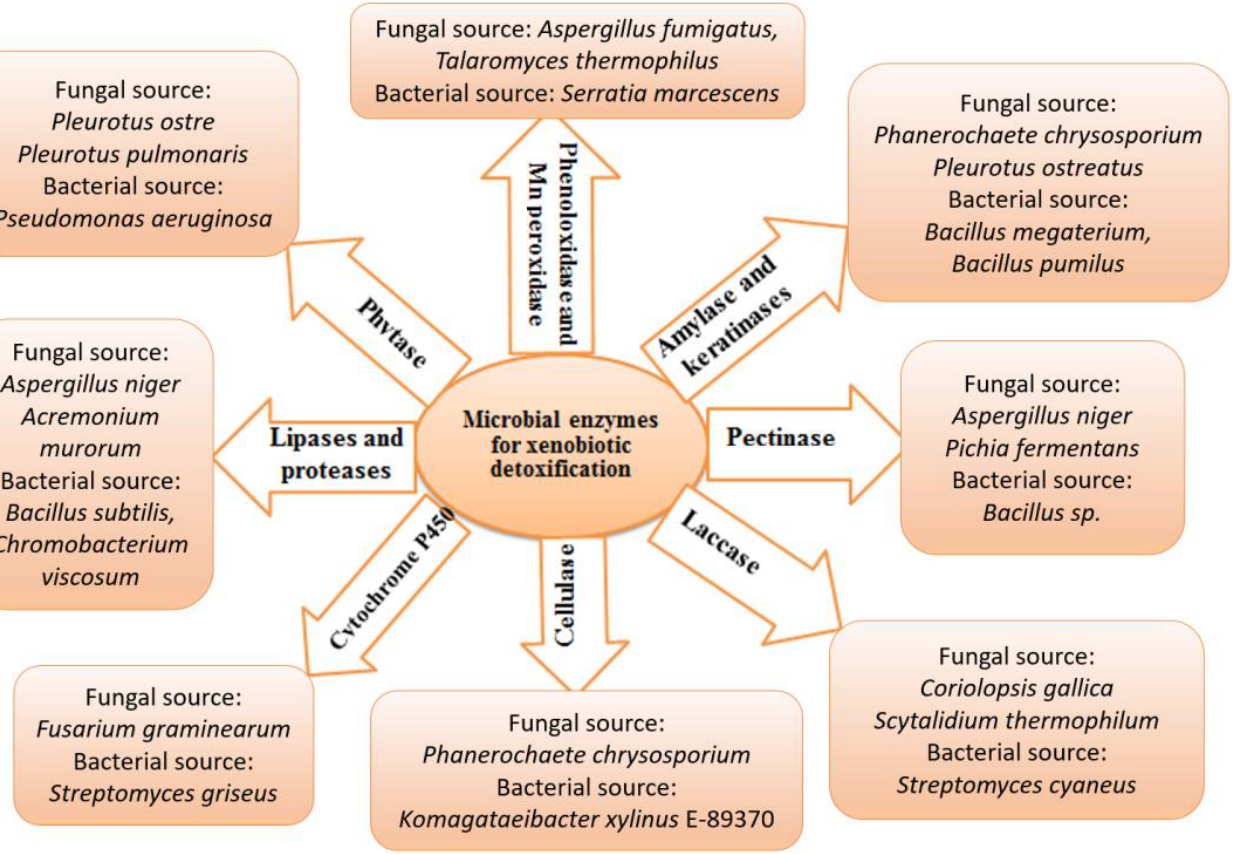
Figure 4. Microbial enzymes in xenobiotic management. This figure summarizes a few representative enzymes and their corresponding microbial sources involved in xenobiotic detoxification.